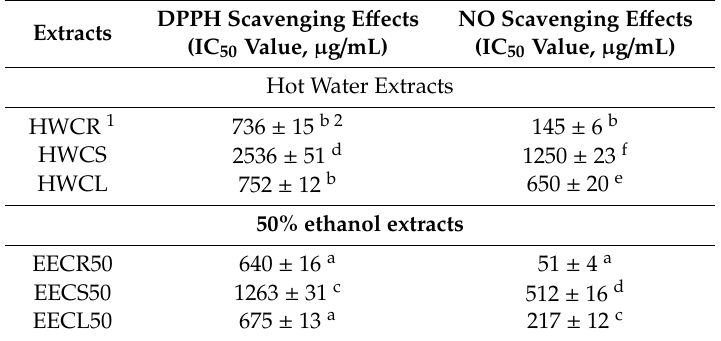
Table 4. The DPPH scavenging and the inhibition of NO formation e ff ects of hot water and 50% ethanol extract of leaves, seeds, and roots from C. cajan